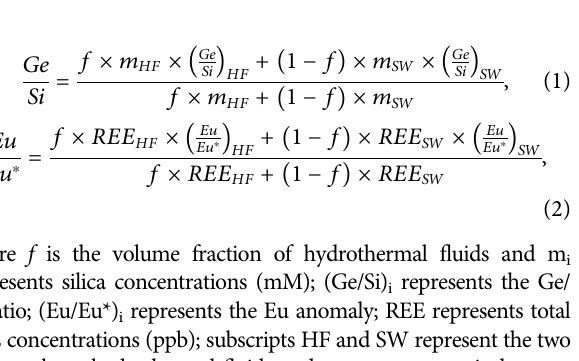
Frontiers in Earth Science |